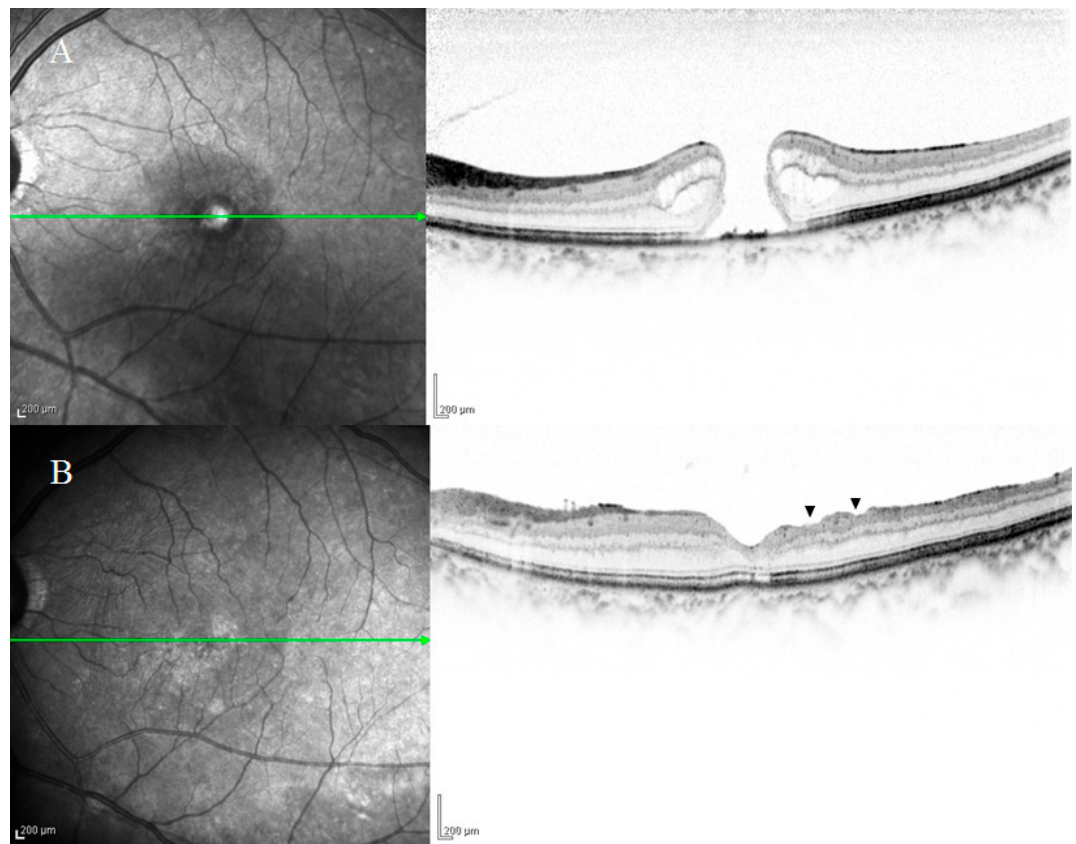
Figure 2. Optical coherence tomography (OCT) images of a patient with an idiopathic macular hole (MH) obtained pre- surgery ( A ) and at 6-months postoperative ( B ). OCT scans frequently showed thinning and irregularity of the inner retinal layer (( B ), black arrowheads), thus indicating that the nerve fiber layer and ganglion cells were highly likely to have been damaged. The patient’s visual acuity was 20/100 before surgery and 20/25 after surgery.